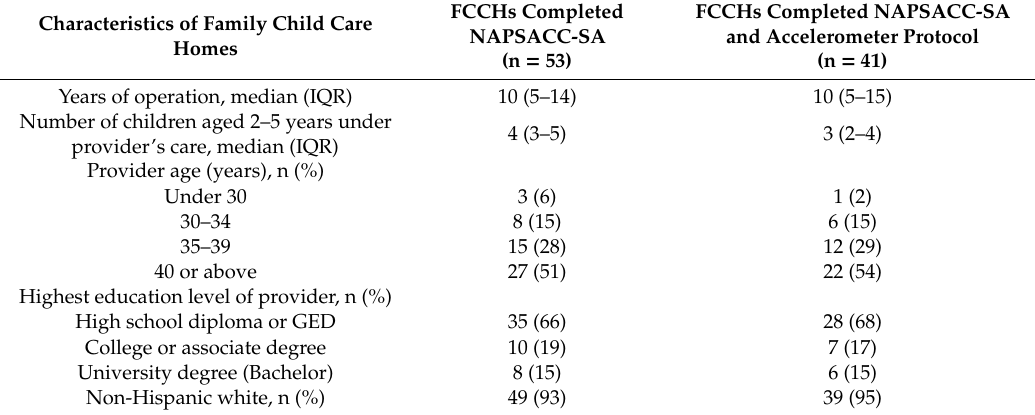
Table 1. Characteristics of family child care homes (FCCHs) and providers. NAPSACC-SA,